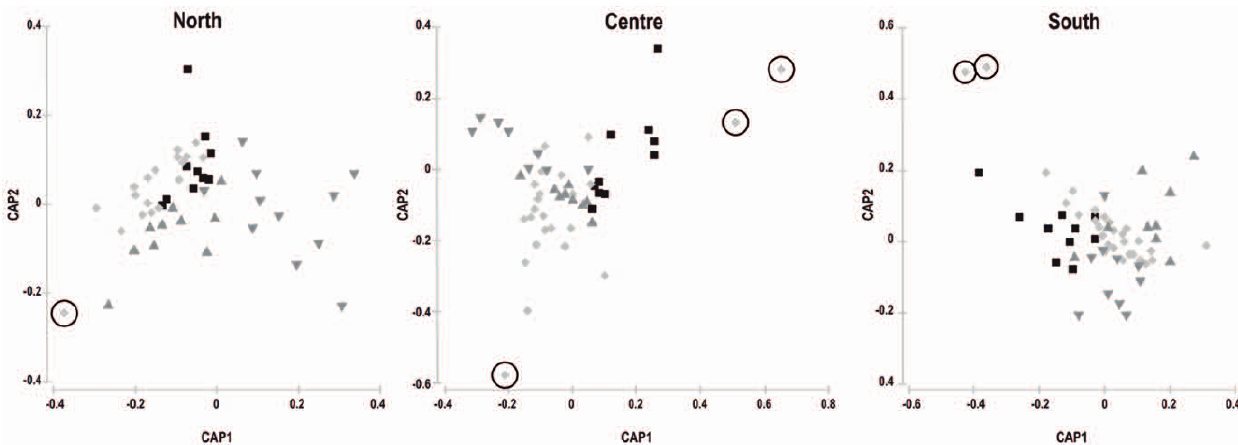
Figure 5. CAP analyses of trace elements (Mg, Zn, Sr, Ba, Pb) from otoliths of settlers. Each panel refers to one of the three regions (North, Centre and South) sampled in the present study. In every panel each of the three sampling sites considered is represented by a different symbol. New samples (representing otoliths of recruits collected in the region considered) are depicted by grey symbols. Dotted circles indicate samples not assigned to any group (see material and methods for further details).